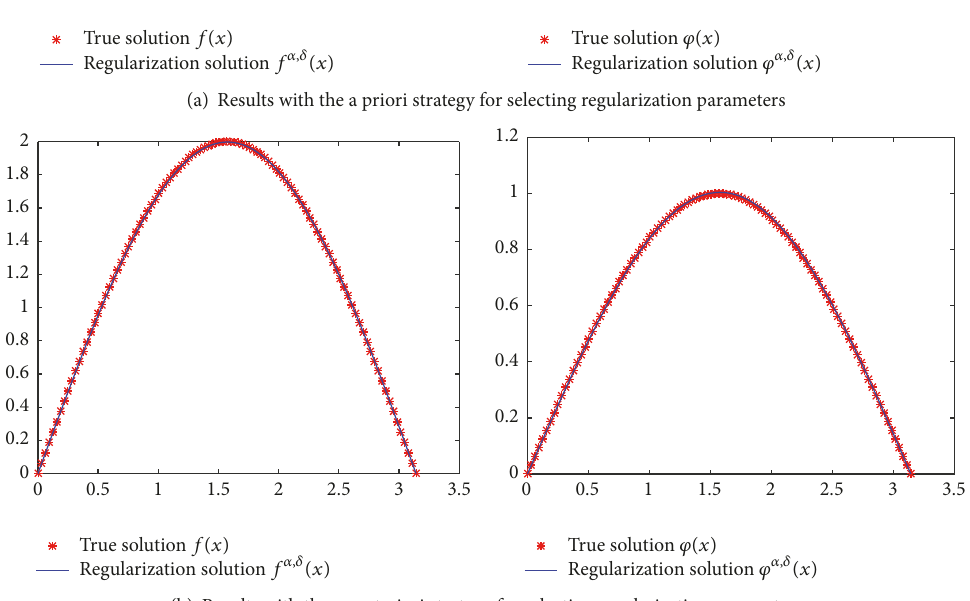
Figure 1: Behaviors of the true and the regularization solution when 𝜌 = 0.05